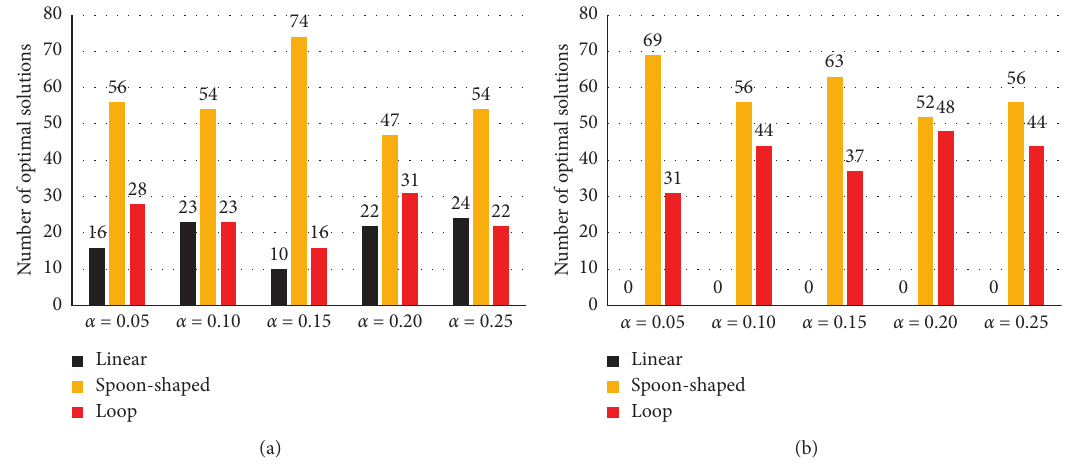
Figure 13: The results with different values of α . (a) Condition 2. (b) Condition